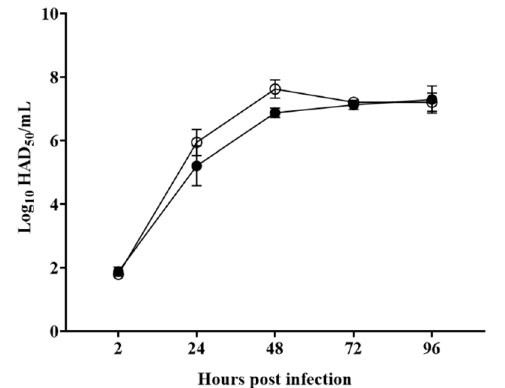
Figure 4. In vitro growth kinetics in primary swine macrophage cell cultures for ASFV-G- ∆ C962R and parental ASFV-G, infected (MOI = 0.01) with ASFV-G- ∆ C962R or parental ASFV-G viruses. Samples were taken from three independent experiments at the indicated time points and titrated. Data represent means and standard deviations. Sensitivity using this methodology for detecting virus: >log10 1.8 HAD 50 /mL. No significant differences in viral yields between viruses were observed at any timepoint which had been tested determined using the Holm–Sidak method ( α = 0.05), without assuming a consistent standard deviation. All calculations were conducted using the software GraphPad Prism version 8.